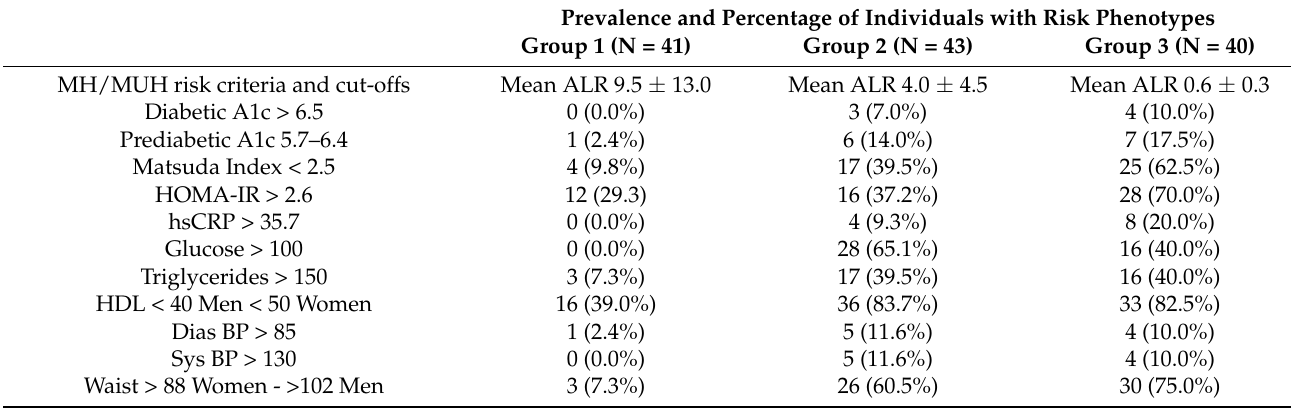
Table 3. Prevalence and percentages of parameters and cut-offs widely used to define metabolic risk and a healthy/unhealthy cardiometabolic profile (MH/MUH) in subjects with adipose tissue dysfunction determined by a mean (H) or (L)ALR. Prevalence and Percentage of Individuals with Risk Phenotypes Group 1 (N = 41) Group 2 (N = 43) Group 3 (N = 40) MH/MUH risk criteria and